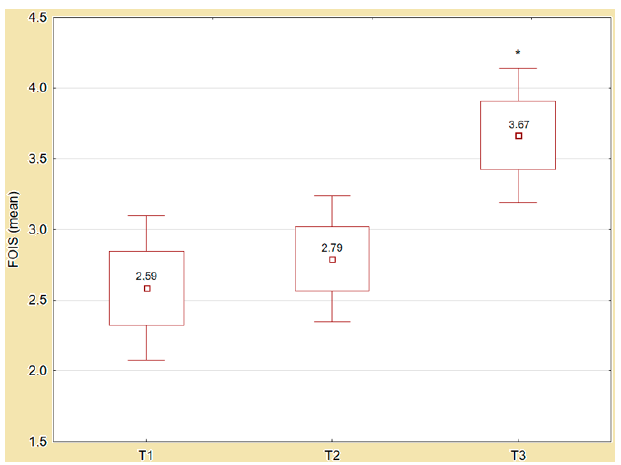
Figure 2. Changes in FOIS values (T1–T3). Abbreviations: T1, hospital discharge; T2, rehabilitation admission; T3, after FEES; * statistically significant value with p = 0.001. The intergroup ANOVA revealed statistically significant differences in diet recommendations at T1, T2, and at T3 based on Functional Oral Intake Scale values ( p = 0.001). In the next step, the posthoc test and effect size analysis were done. Table 2 presents the results of the posthoc tests and differential values in the aspects for FOIS at time of procedure. Analysis of the effect size revealed a large effect for FOIS ( η 2 = 0.190) after FEES at T3.